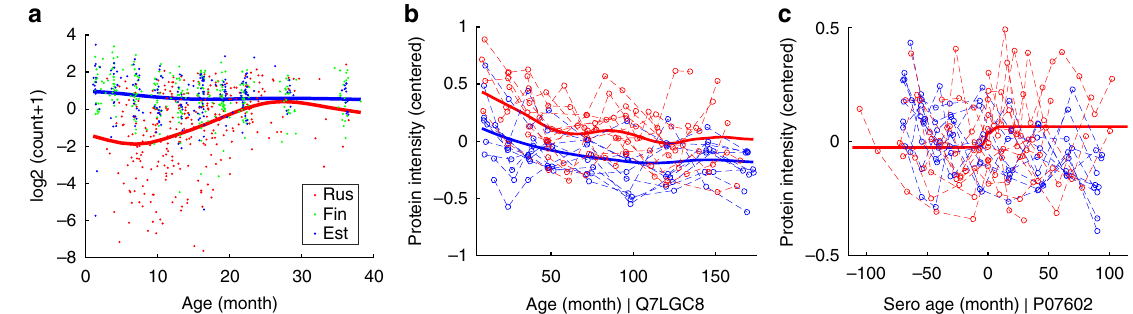
Fig. 4 LonGP results. a LonGP regression results for Lipid A biosynthesis pathway (Metagenomics data set). Y -axis shows the log 2 transformation of the normalised read counts of the samples. Russian, Finnish, and Estonian infant samples are depicted by the red, green, and blue colour dots, respectively. The blue line shows the nonlinear age trend of Finnish and Estonian infants. The red line shows the age trend of Russian infants. The red and blue lines are generated as the sum of components y ¼ f ð 1 Þ se ð age Þ þ f ð 3 Þ ð rus Þ þ f ð 5 Þ ð rus ´ age Þ . b Cumulative effect y ¼ f ð 1 Þ se ð age Þ þ f ð 2 Þ ð group Þ þ f ð 3 Þ ð group ´ age Þ against bi bi ´ se bi bi ´ se real (centred) intensity of protein Q7LGC8 (Proteomics data set). Red lines are cases and blue lines are controls. c Predicted mean of the sero component for protein P07602 (Proteomics data set). The dashed red lines show the measurements of cases and the dashed blue lines are controls. x -axis indicates time from seroconversion and y -axis is the centred protein intensity. Mean seroconversion age of all cases (79.42 month) is used as the seroconversion age for controls. The solid red line corresponds to the mean of the seroconversion component y ¼ f ð 4 Þ ns ð sero (Table 1 and Supplementary Table S3). For two selected proteins, Prosaposin (Uniprot Accession P07602) and Opioid-binding protein/cell adhesion molecule (Uniprot Accession Q14982), protein expression levels were best explained by the LonGP